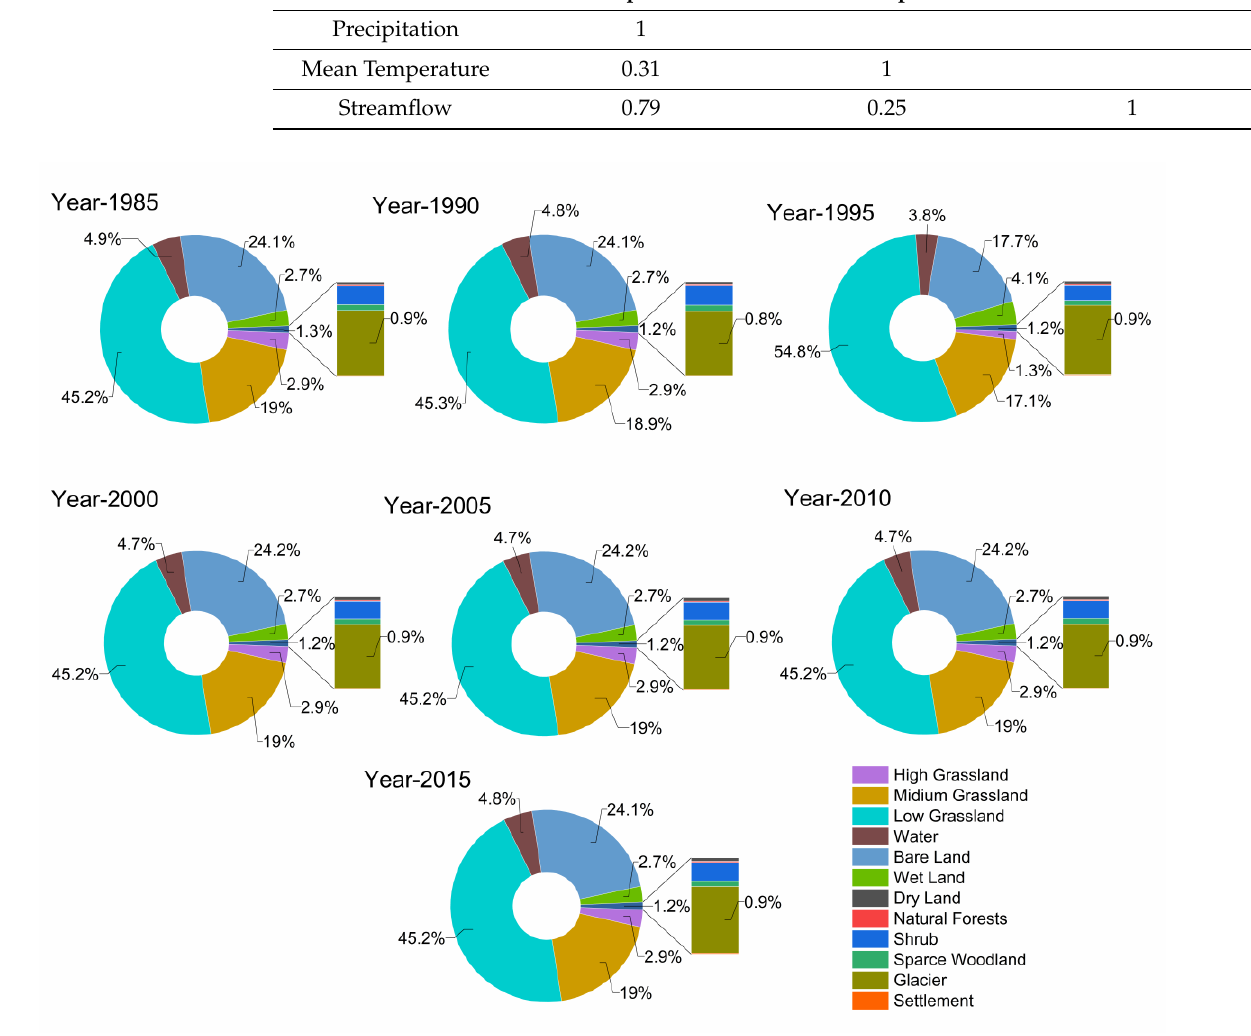
Figure 10. Percentage of area coverage by each land cover from 1985 to 2015 in the YRSR.